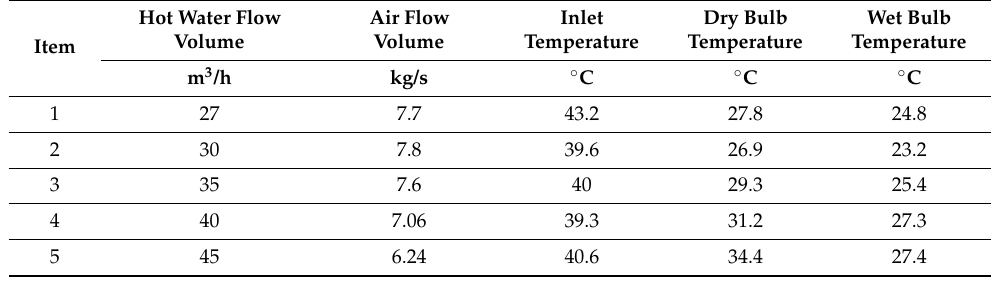
Table 3. Comparison of tested value and calculated value for the overall heat transfer coefficients K pw under several test conditions.